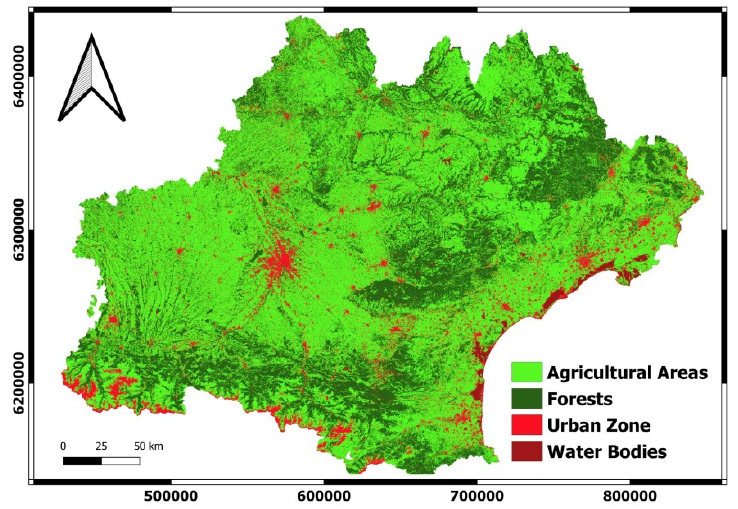
Figure 2. From the initial 16 classes, 4 global classes were derived: urban zones, bodies of water, agricultural areas, and forests.